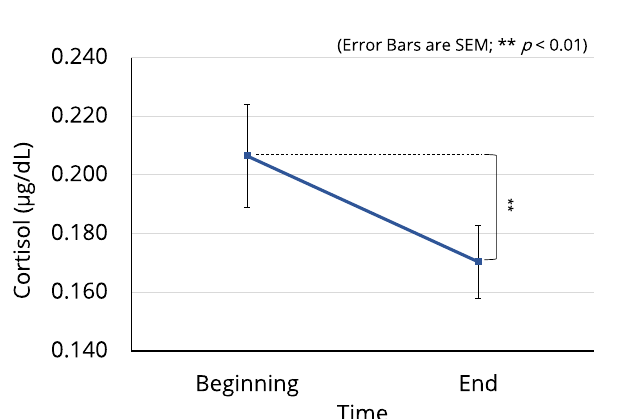
Figure 4. Overall change in cortisol level of participants from the beginning to the end of the experiment. A significant main effect of time was found ( p < 0.01 ) . The figure illustrates a significant decrease ( p < 0.01 ) in cortisol